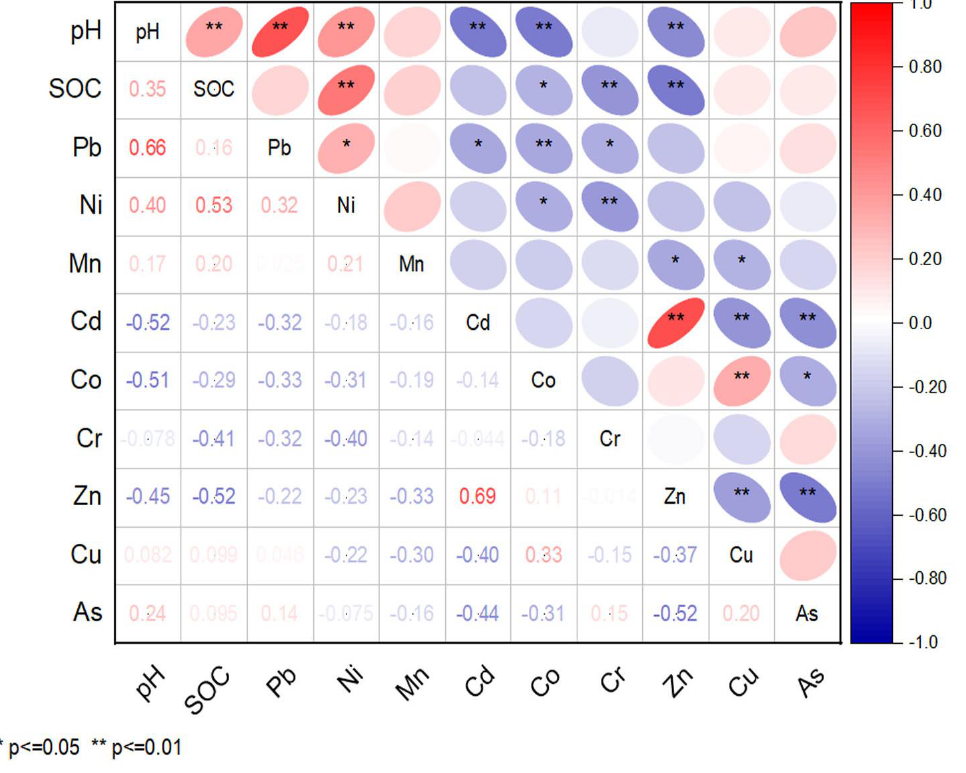
Figure 5. Correlation plot of the soil PTE contents with main physicochemical properties. * Correlation is significant at the 0.05 level, ** correlation is significant at the 0.01 level. SOC—soil organic carbon.